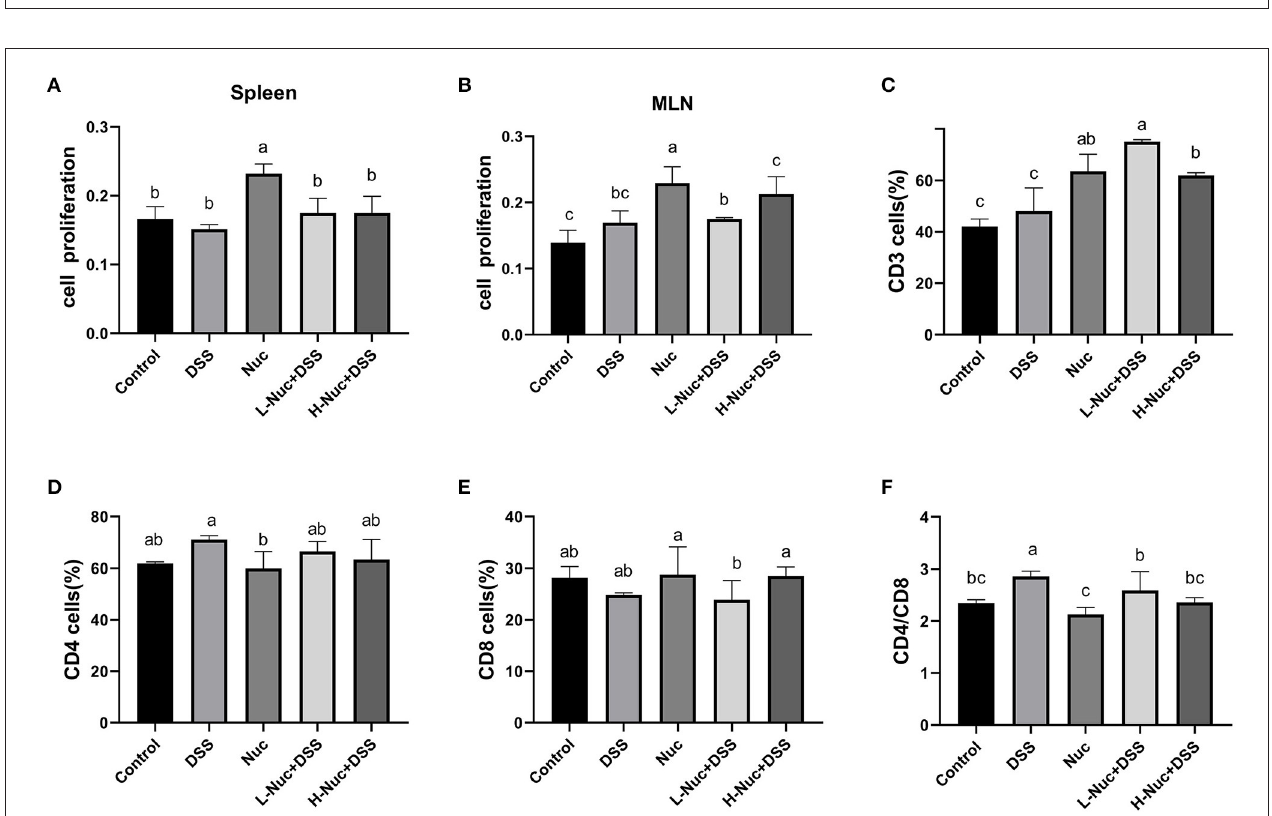
FIGURE 3 | Nuciferine regulated T cell proliferation and differentiation ( n = 6). Effects of nuciferine on T cell proliferation in spleen (A) and mesenteric lymph nodes (B) . (C) The percentage of CD3 cells in the mesenteric lymph nodes. (D) The percentage of CD4 cells in the mesenteric lymph nodes. (E) The percentage of CD8 cells in the mesenteric lymph nodes. (F) Comparison on the ratio of CD4/ CD8 between groups, The dataare expressed as the mean ± S.D. Significant differences were considered at P < 0.05. a − c Bars without the same superscripts differ significantly ( P < 0.05).